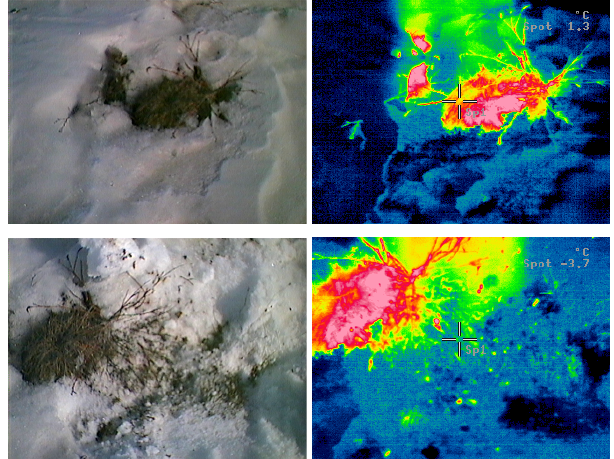
Figure 8 Figure 8. IR camera temperatures denote 1.3 ◦ C at the top of tus- sock and − 3.7 ◦ C at the snow surface at the TZ site on 19 April 2010, suggesting a sharp difference between the tussock top and the snow surface (image courtesy of H. Enomoto).